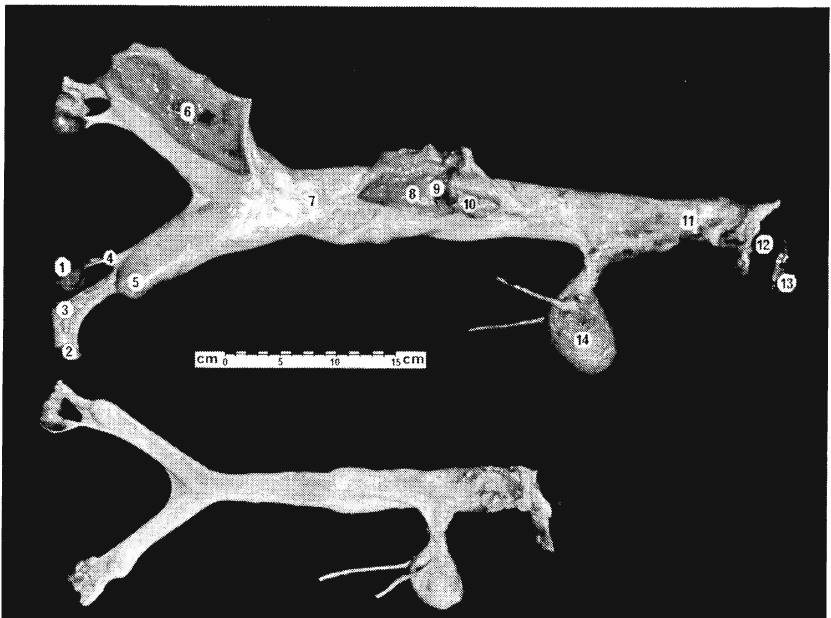
Fig. 5. Difference in size between the tubular genitalia of a sexually mature (2! year old) Burchell's zebra mare (upper) and an immature yearling. Both tracts are viewed ventrally. Legend: (1) = right ovary; (2) = fimbriated end offallopian tube; (3) = fallopian tube enclosed by